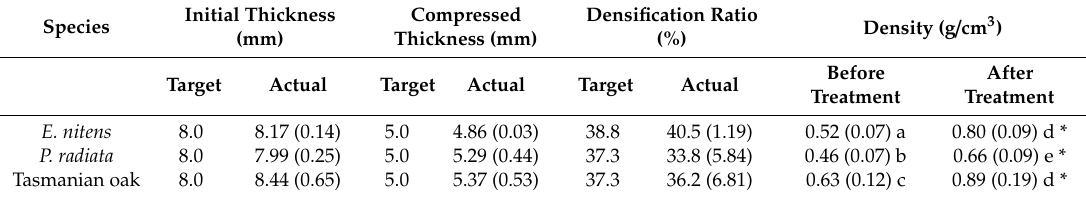
Table 1. Actual and target compressed thickness (mm), densification ratio (%), average values of oven-dry initial density, and final density after the THM (Thermo-Hydro Mechanical Treatment) (g / cm 3 ). Standard deviation presented in parentheses ( n = 30).